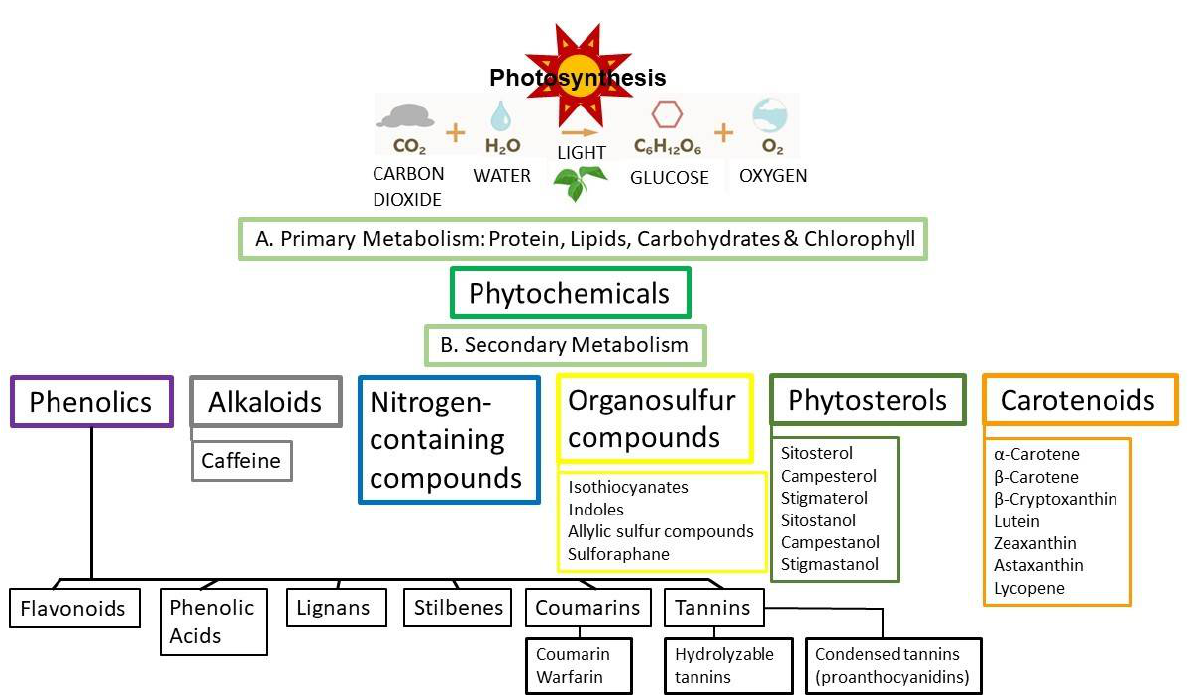
Figure 4. Photosynthesis—cartoon of life-giving oxygen generation plus ( A ) primary metabolism in plants leading to phytochemicals and ( B ) secondary metabolism leading to the major classes of compounds along with examples of phytochemicals under each classification and the major subgroups of